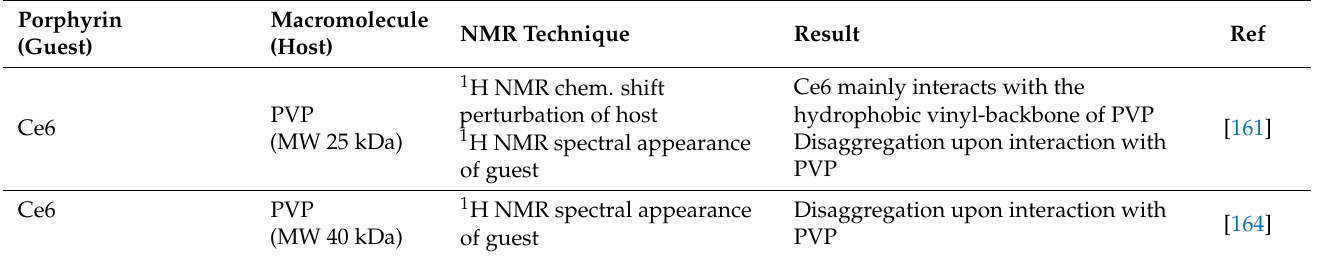
Table 2. Summary of NMR interaction studies between porphyrins and